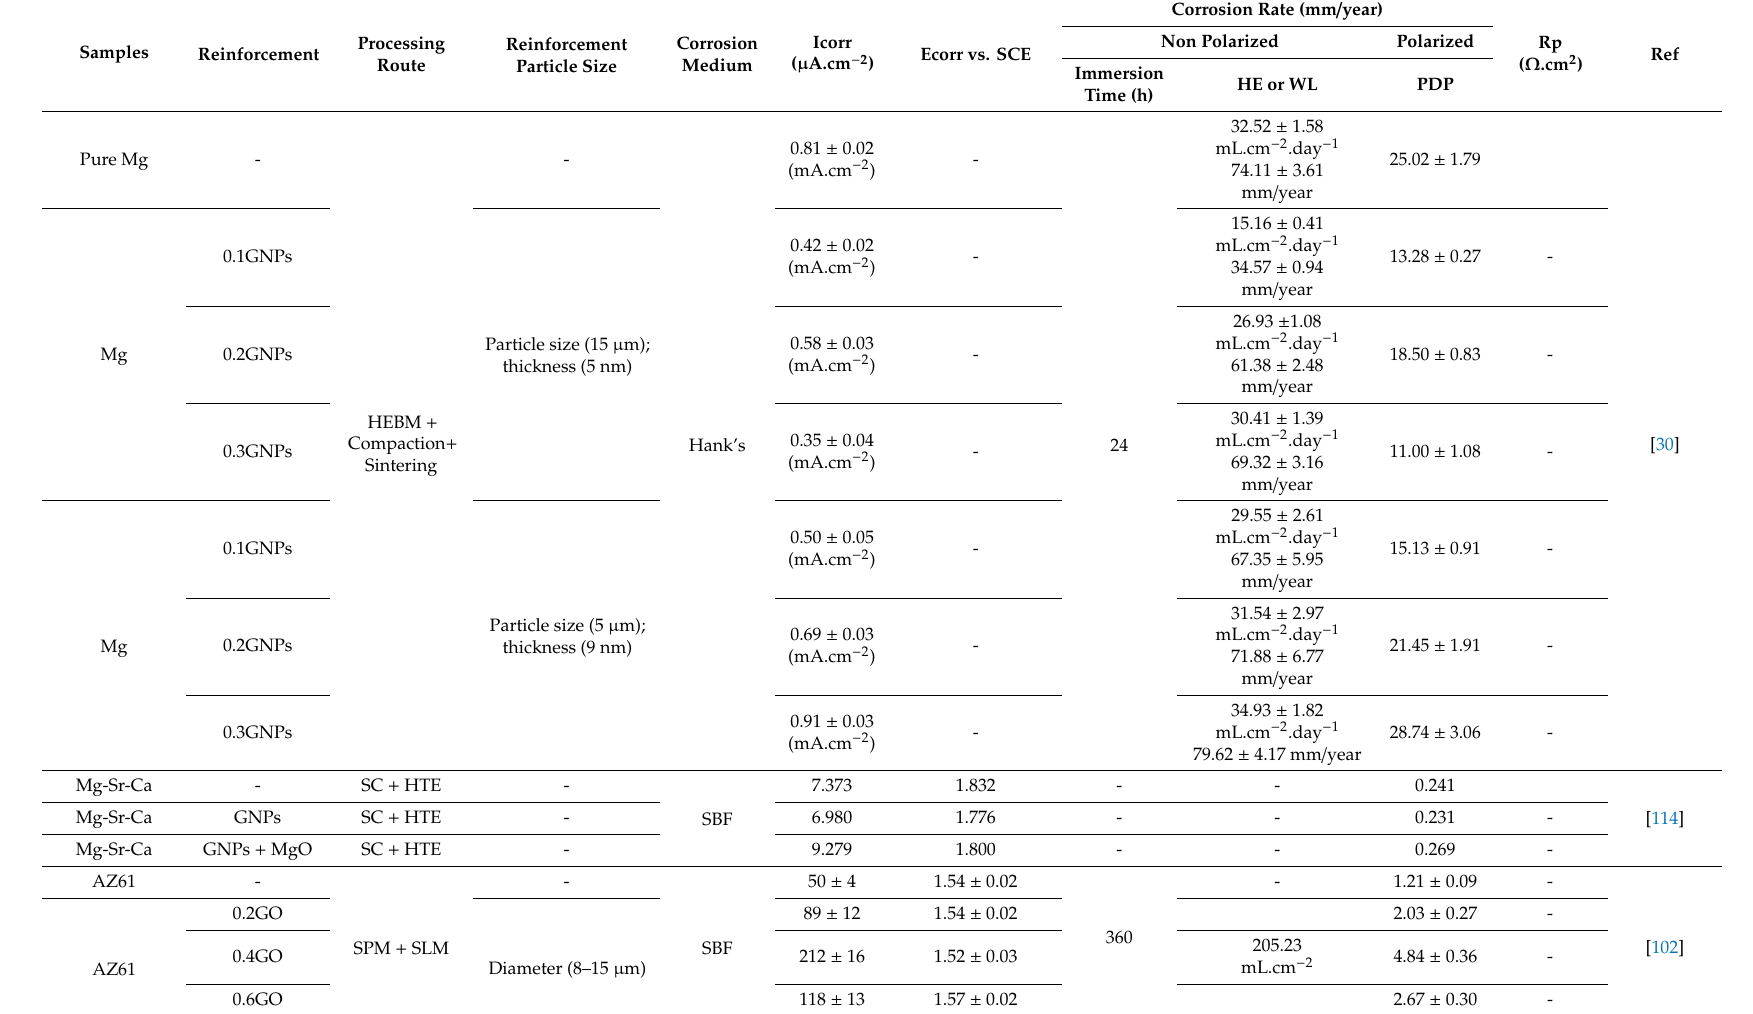
Table 3. Corrosion properties of Mg-based nanocomposite containing